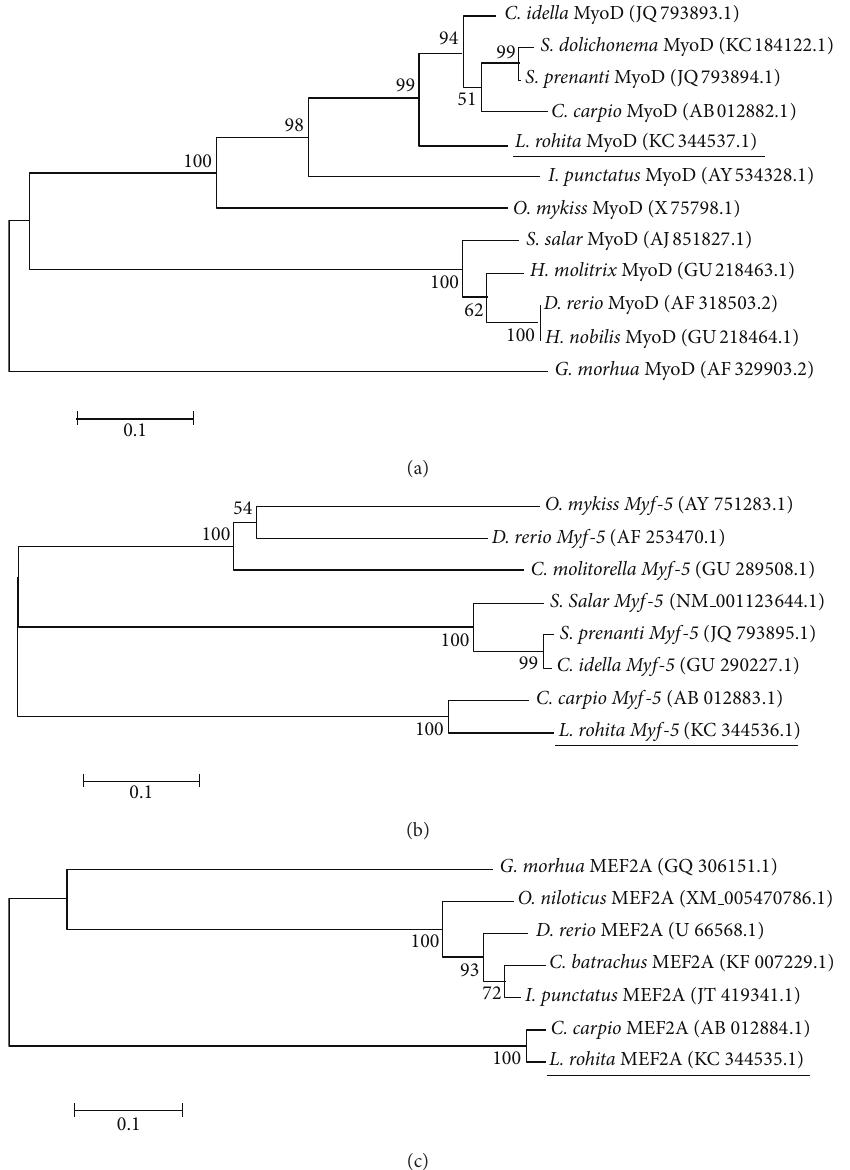
Figure 4: Molecular phylogenetic tree of (a) MyoD, (b) myf-5, and (c) MEF2A. This dendrogram is based on the translated amino acid sequences. GenBank accession numbers are given in the brackets and sequences acquired from this study are underlined accordingly.